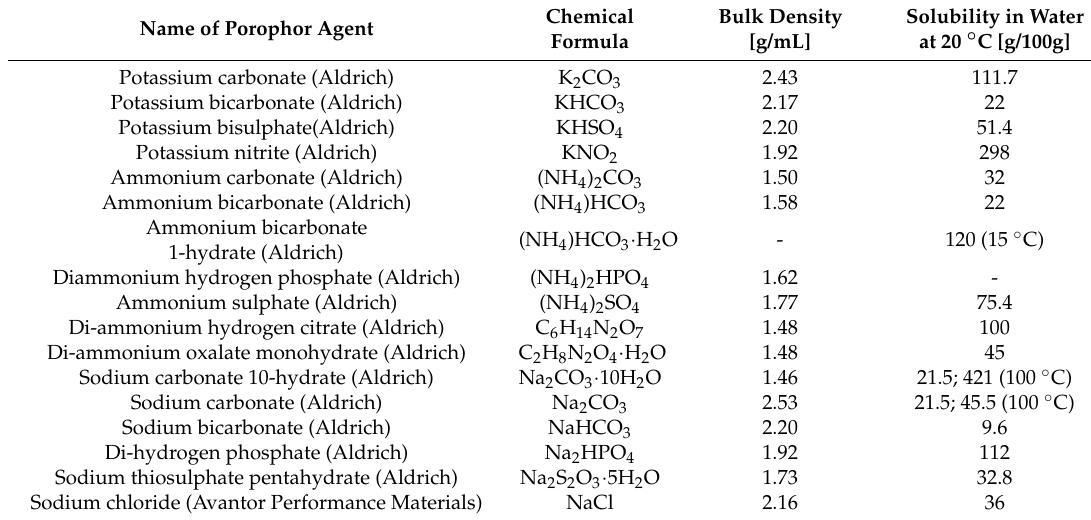
Table 1. The applied inorganic salts. The data in the table are taken from the safety data sheets provided by the manufacturer of each